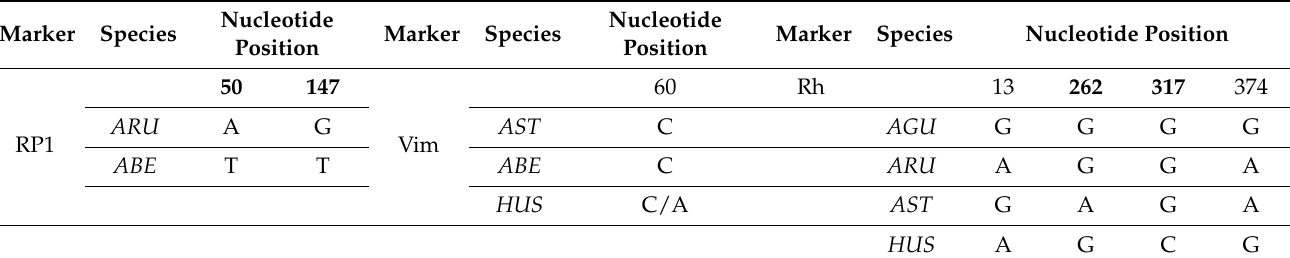
Table 4. Single nucleotide polymorphisms (SNPs) identified in the nuclear